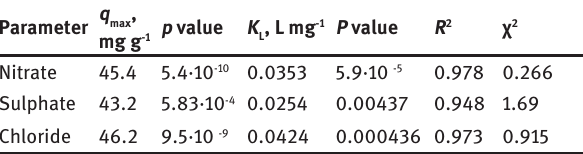
Table 4: The parameters of the Langmuir model of biosorption of Cr(III) ions for different anions